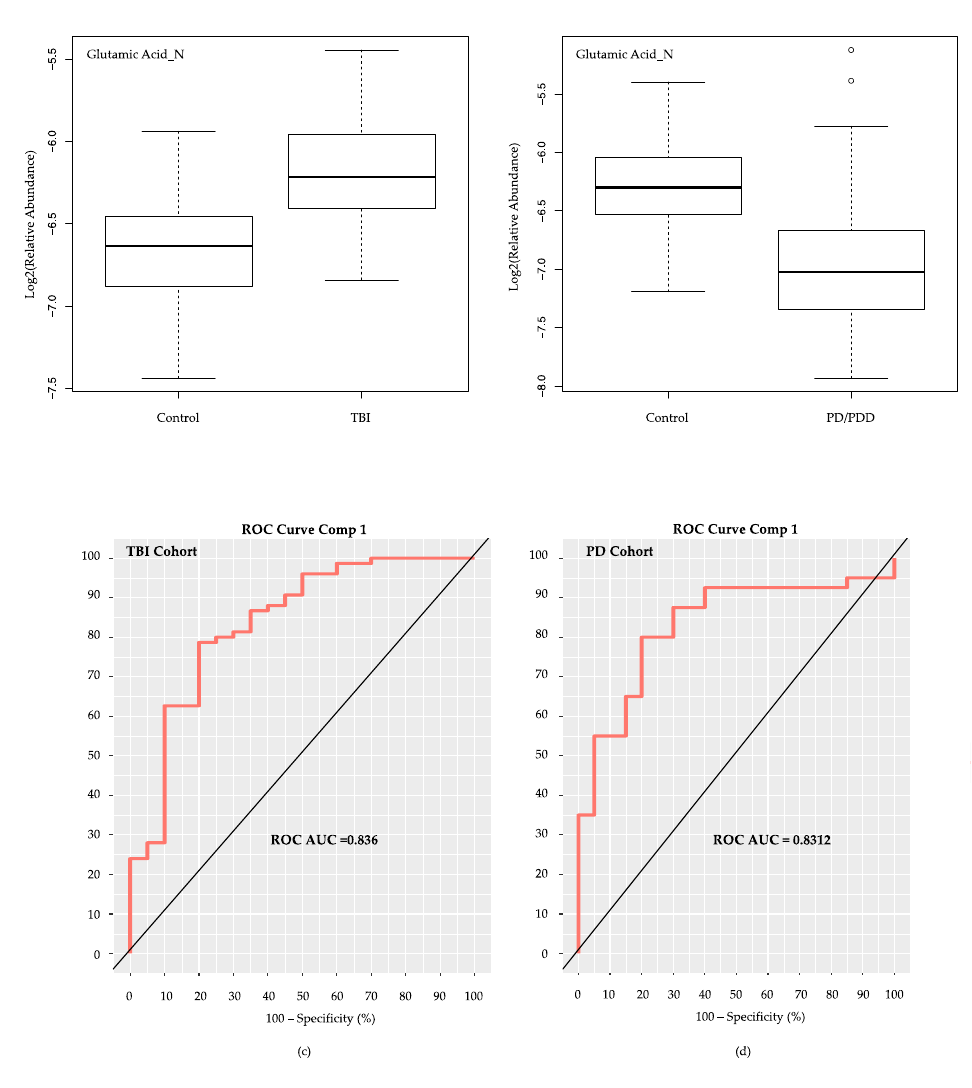
Figure 6. Classification of cohort groups using Glutamic Acid as the sole metabolite. Log2 (relative abundance) values for Glutamic Acid in the two study cohorts are depicted via boxplots in panels ( a ) and ( b ). For the subacute TBI cohort ( a ) Glutamic Acid is elevated in TBI cases compared to controls. In the PD cohort ( b ) Glutamic Acid was elevated in controls compared to the PD/PDD cases. ROC AUC results are nearly identical using the mixOmics PLS-DA model with only Glutamic Acid as classifier of the TBI (subacute mTBI) cases from TBI controls ( c ), as well as the PD (PD/PDD) cases from PD controls ( d ). Comp = PLS-DA model component. TBI = traumatic brain injury. mTBI = mild TBI. PD = Parkinson’s disease. PDD = PD dementia. ROC AUC = receiver operating characteristic area under the curve.